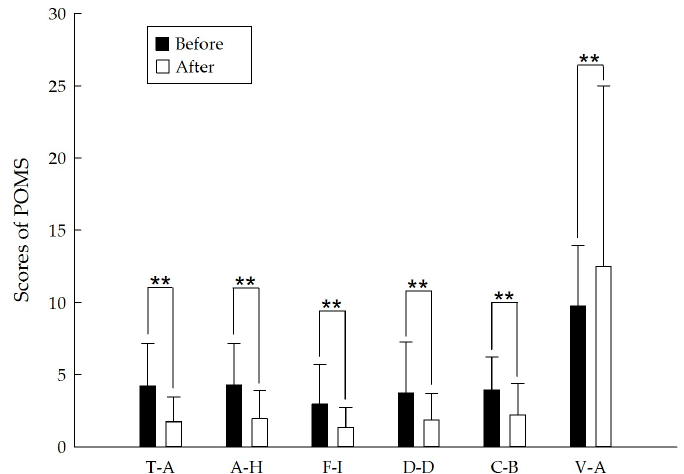
Figure 6. POMS scores before and after the short forest bathing program. T-A: tension-anxiety; A-H: anger-hostility; F-I: fatigue-inertia; D-D: depression-dejection; C-B: confusion-bewilderment; V-A: vigor-activity. N = 128, mean ± standard error. ** p < 0.01, paired-sample t test.